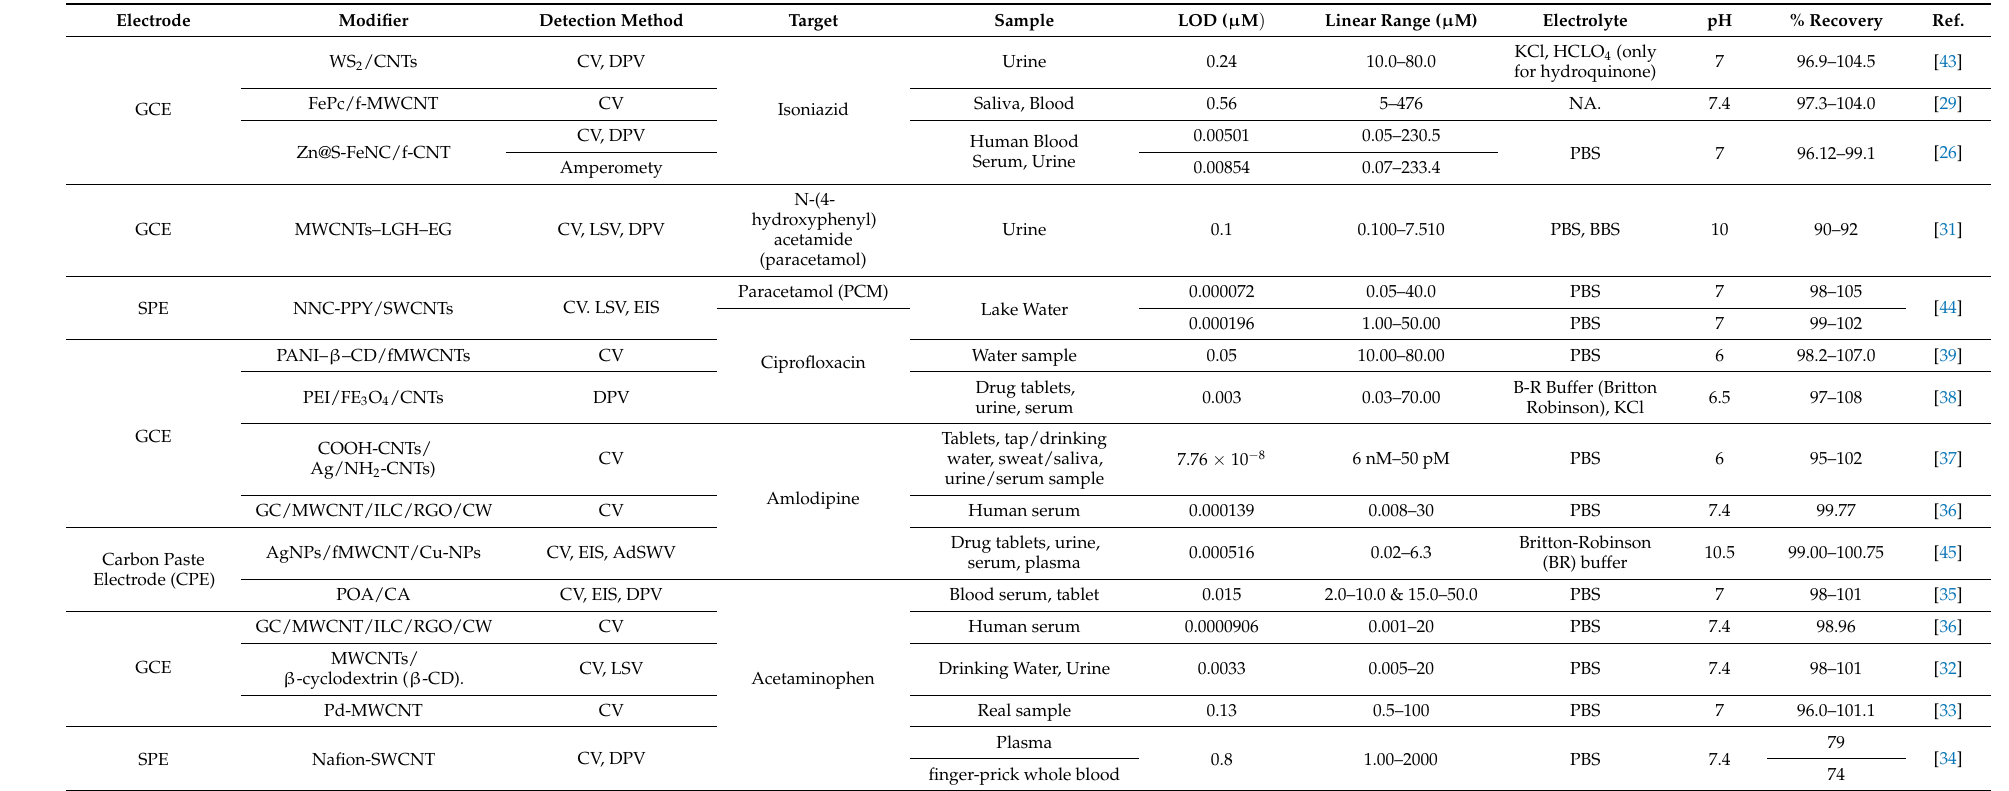
Table 1. Summary of CNTs for pharmaceutical sensor